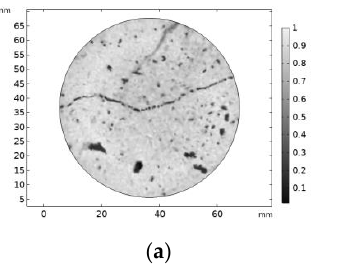
Figure 10. CT section grayscale map with porosity conversion. ( a ) Grayscale image; ( b ) Porosity; ( c ) Permeability.